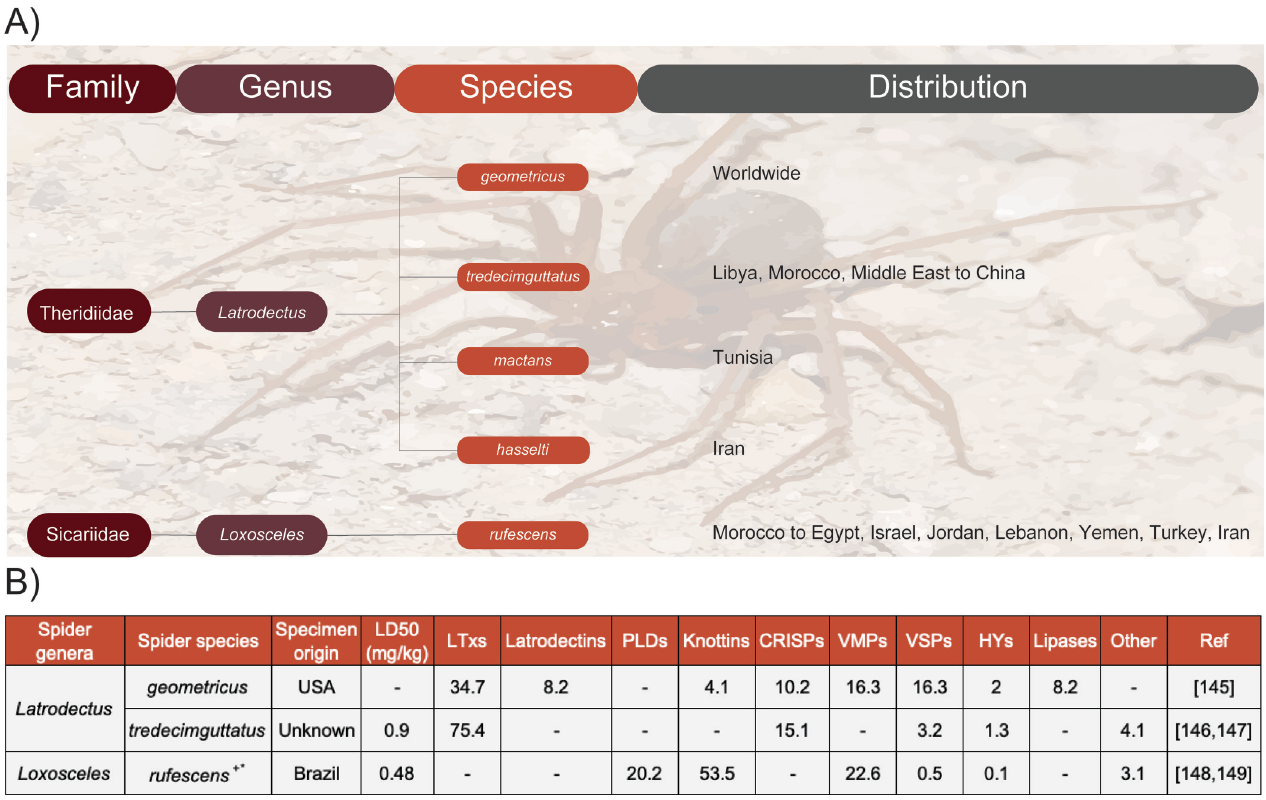
Fig 3. Medically relevant spiders in North Africa and the Middle East. (A) Phylogeny and geographic distribution and (B) reported toxicity and available venom proteome or transcriptome ( + ) data are shown [145–149]. Specifically, the table presents the genera, species, the origin of the reference proteome or transcriptome, and the median lethal dose in mice (LD 50 ; mg/kg). It also illustrates the relative abundance of LTxs, Latrodectins, PLDs, ICKs (Knottins), CRiSPs, VMPs, VSPs, HYALs, and lipases. All components are represented as relative wet weight abundance in %. � proxy from Loxosceles intermedia was used. Notably, spider venom composition may vary depending on region. CRiSP, cysteine-rich secretory protein; HYAL, hyaluronidase; LTx, latrotoxin; PLD, phospholipase-D; VMP, venom metalloproteinase; VSP, venom serine